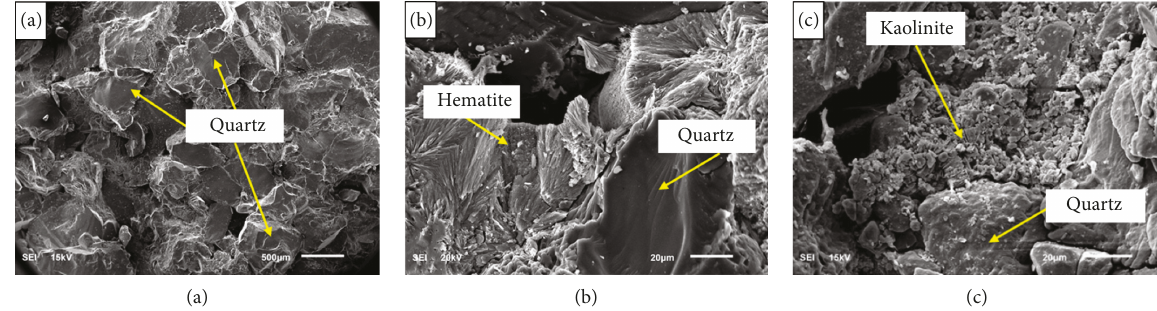
Figure 4: SEM photomicrographs showing (a) quartz arenite sandstone (quartz-rich sandstone), (b) ferruginous sandstone, (c) argillaceous